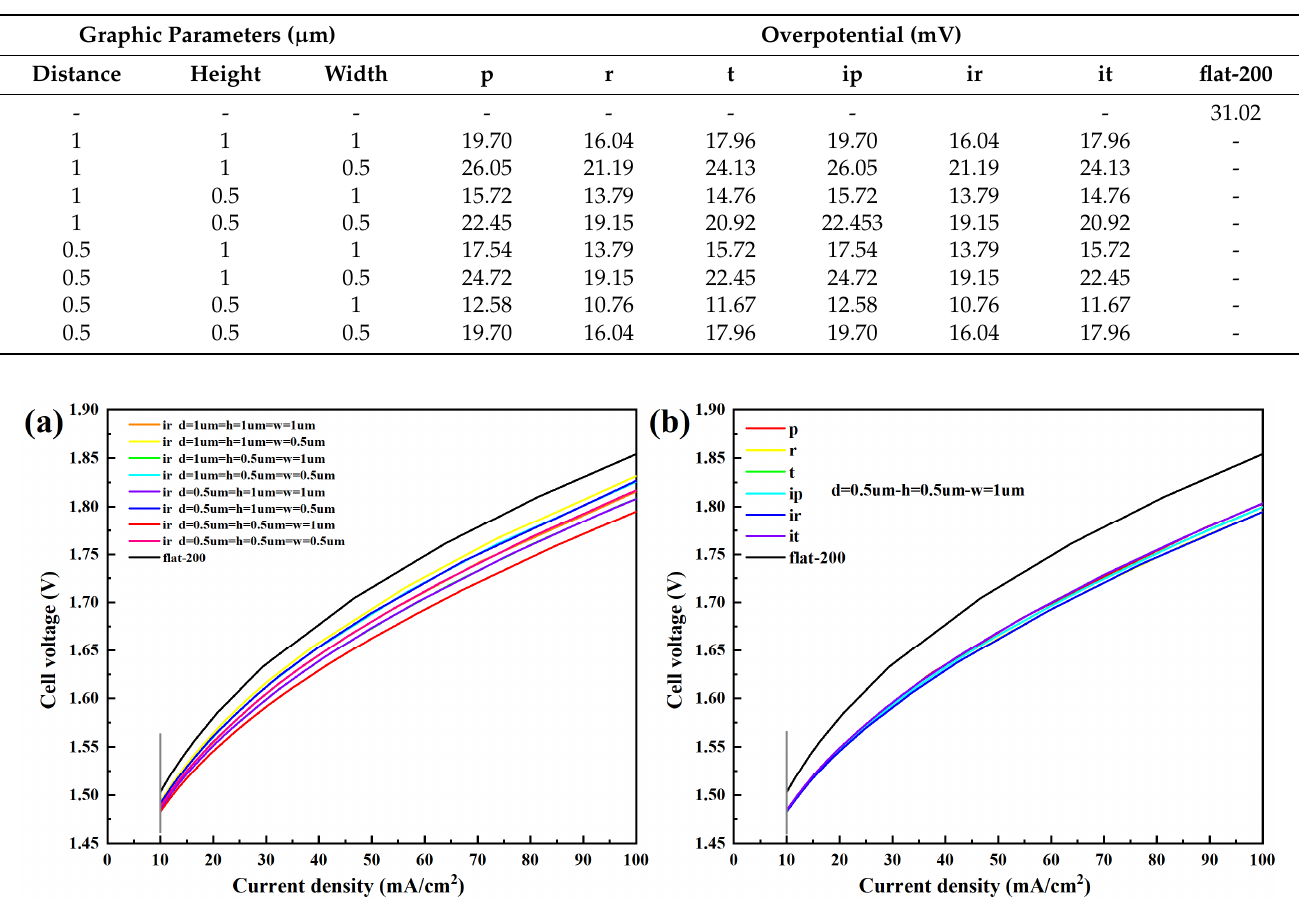
Table 2. The overpotentials of micro-nano surface electrodes with different structure types and graphic parameters and the vertical flat electrode under the same current density of 10 mA cm − 2 .